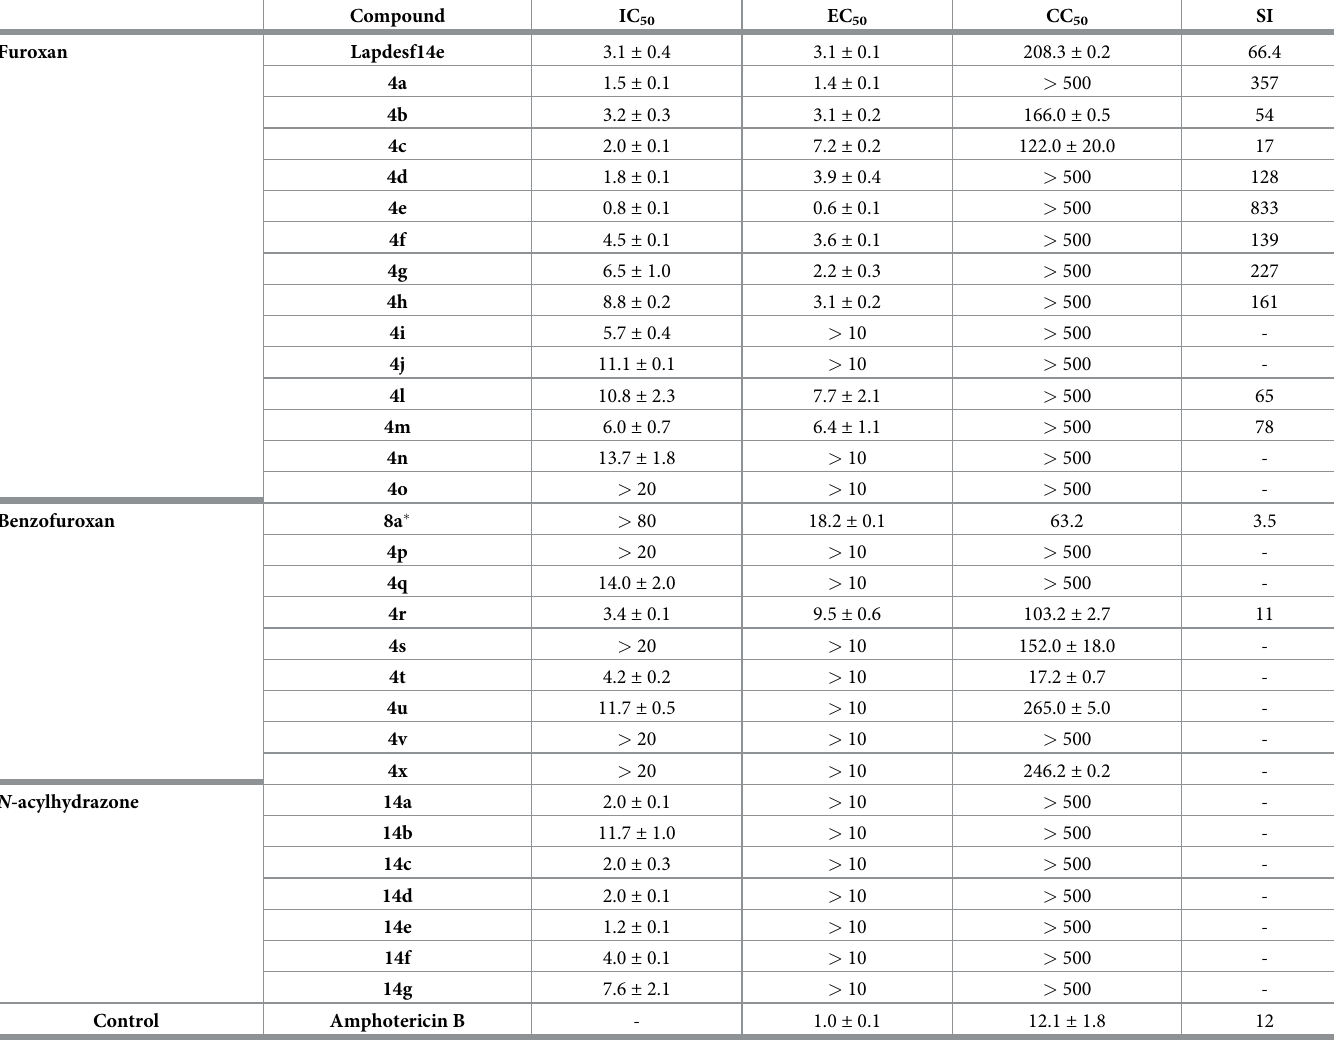
Table 2. Inhibition of CPB, biological activities, and safety by furoxan and benzofuroxan derivatives ( μ